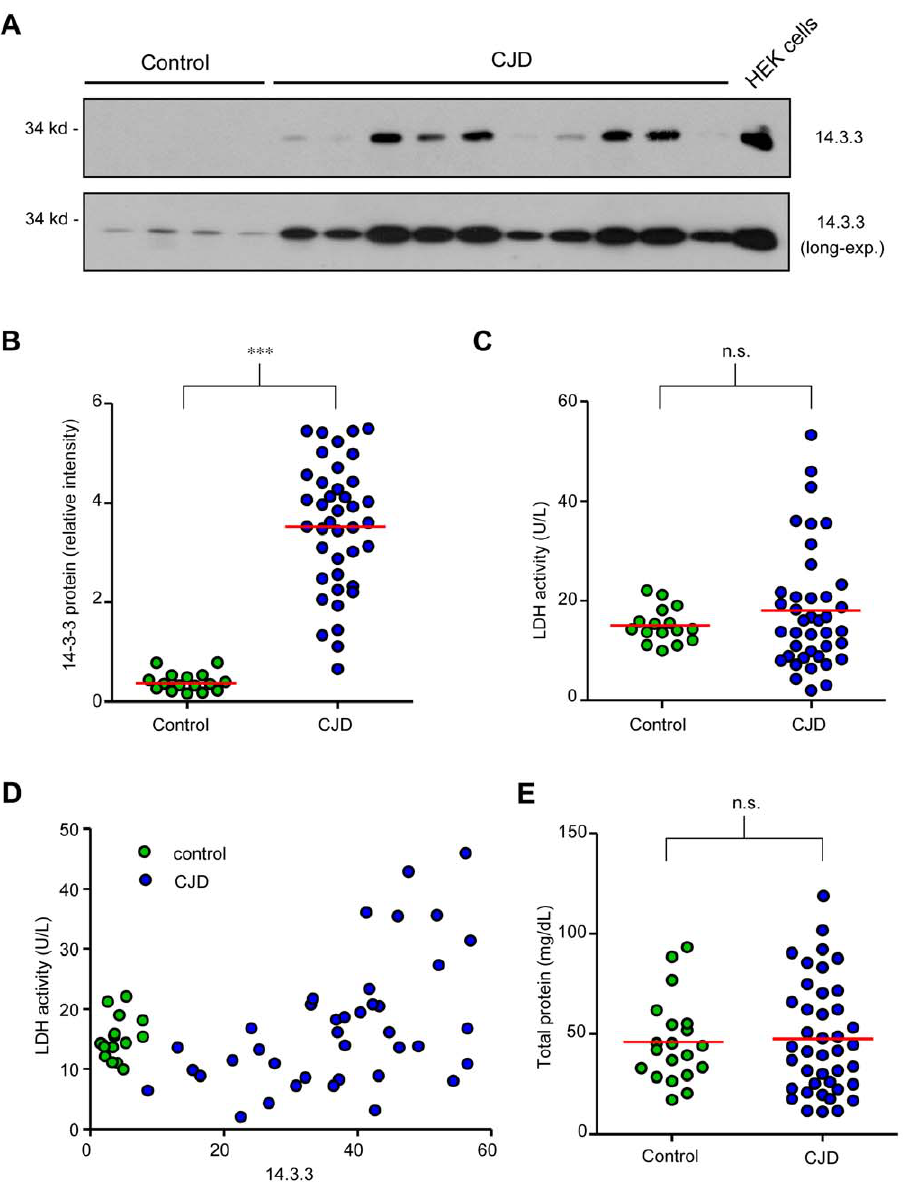
Figure 1. Low correlation between 14-3-3 protein levels and LDH activity in CSF of CJD patients. CSF samples from CJD patients (N=40) and non-CJD controls (N=16), were obtained by lumbar puncture. Then, A. 14-3-3 levels in CSF were analyzed by Western blot. B. Relative levels of 14-3-3 protein band were quantified using densitometric analysis. C. LDH activity was measured in each sample as described in Material and Methods. D. A correlation between 14-3-3 protein and LDH activity from panels B and C is presented. E. Quantitative analysis of total protein levels in CSF samples of panel A was performed. In B, C and E the red line represents the mean of all samples analyzed. Statistical significance was calculated using Student’s t-test.